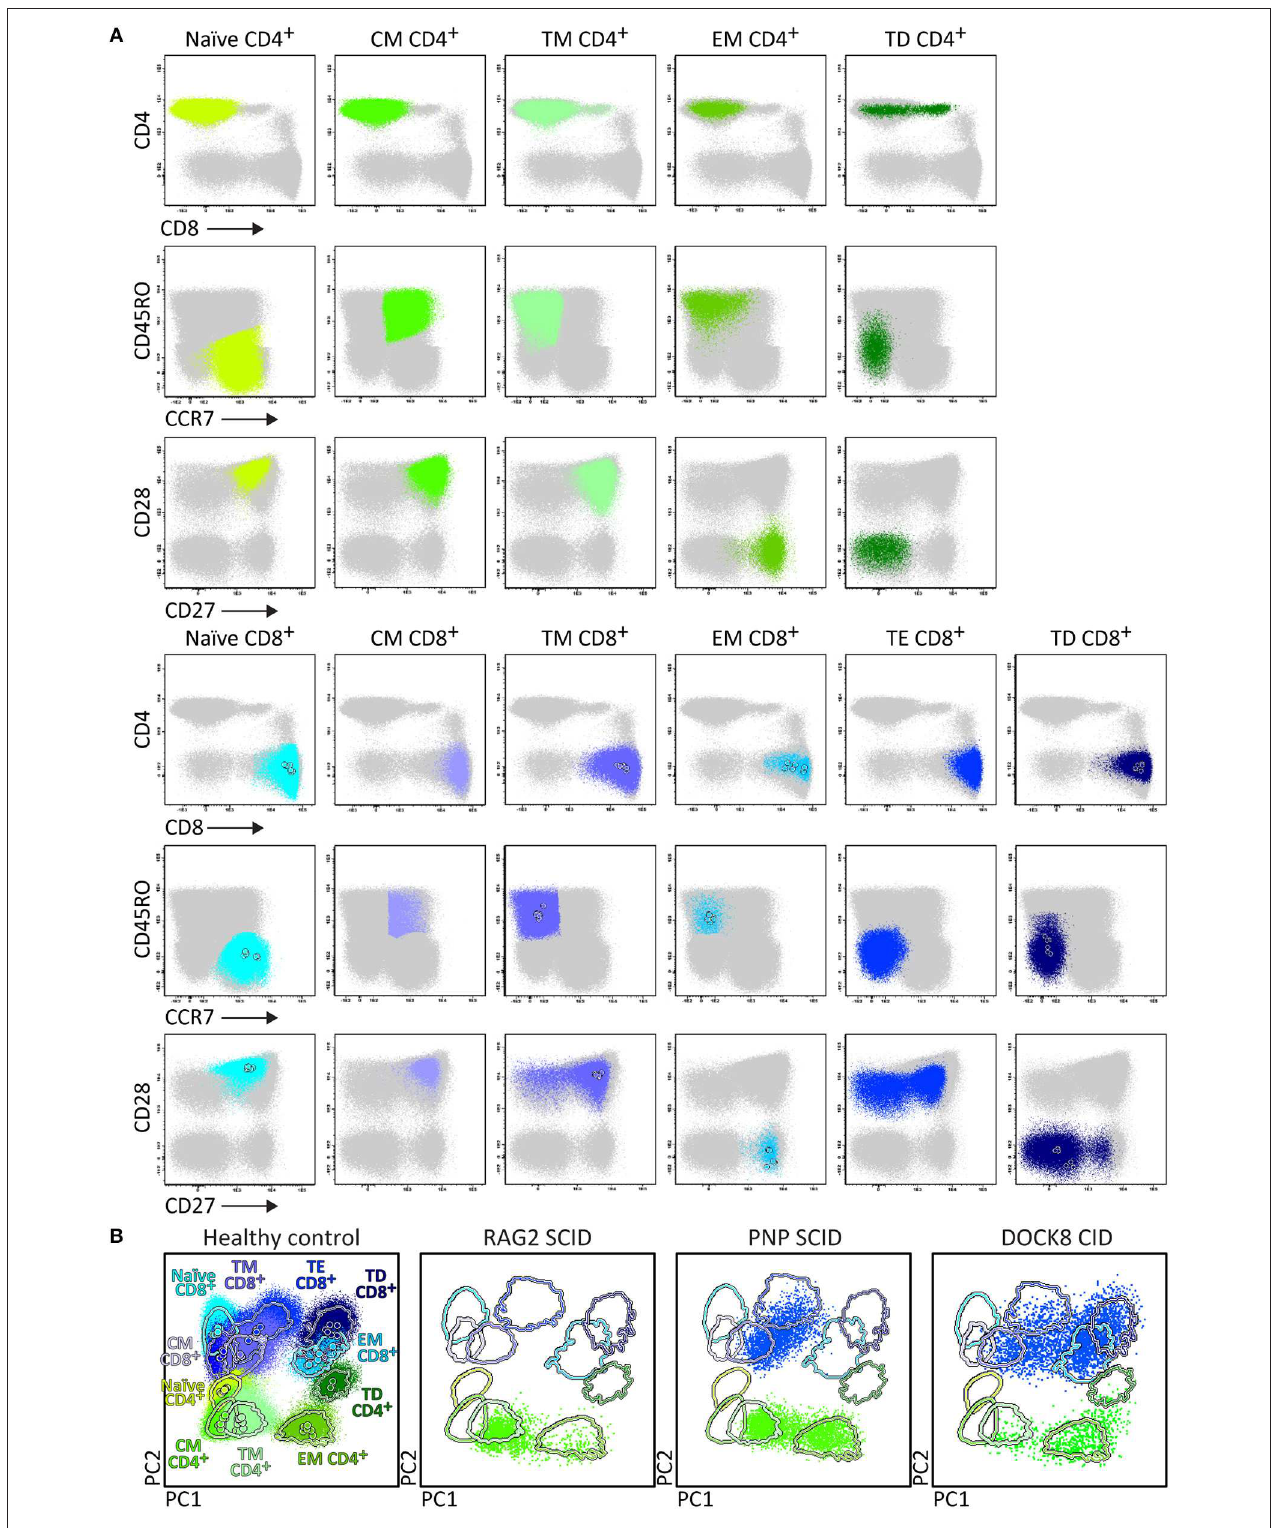
FIGURE 7 | Application of the T-cell panel tube in healthy controls and PID patients with T-cell defects. Analysis of circulating T-cell subsets (FS/SS lo CD3 + ) identified within 1 × 10 6 blood leukocytes using the markers from the T-cell panel tube: naïve (CD45RO − CCR7 + CD27 + CD28 + ), Central Memory (CM) (CD45RO + CCR7